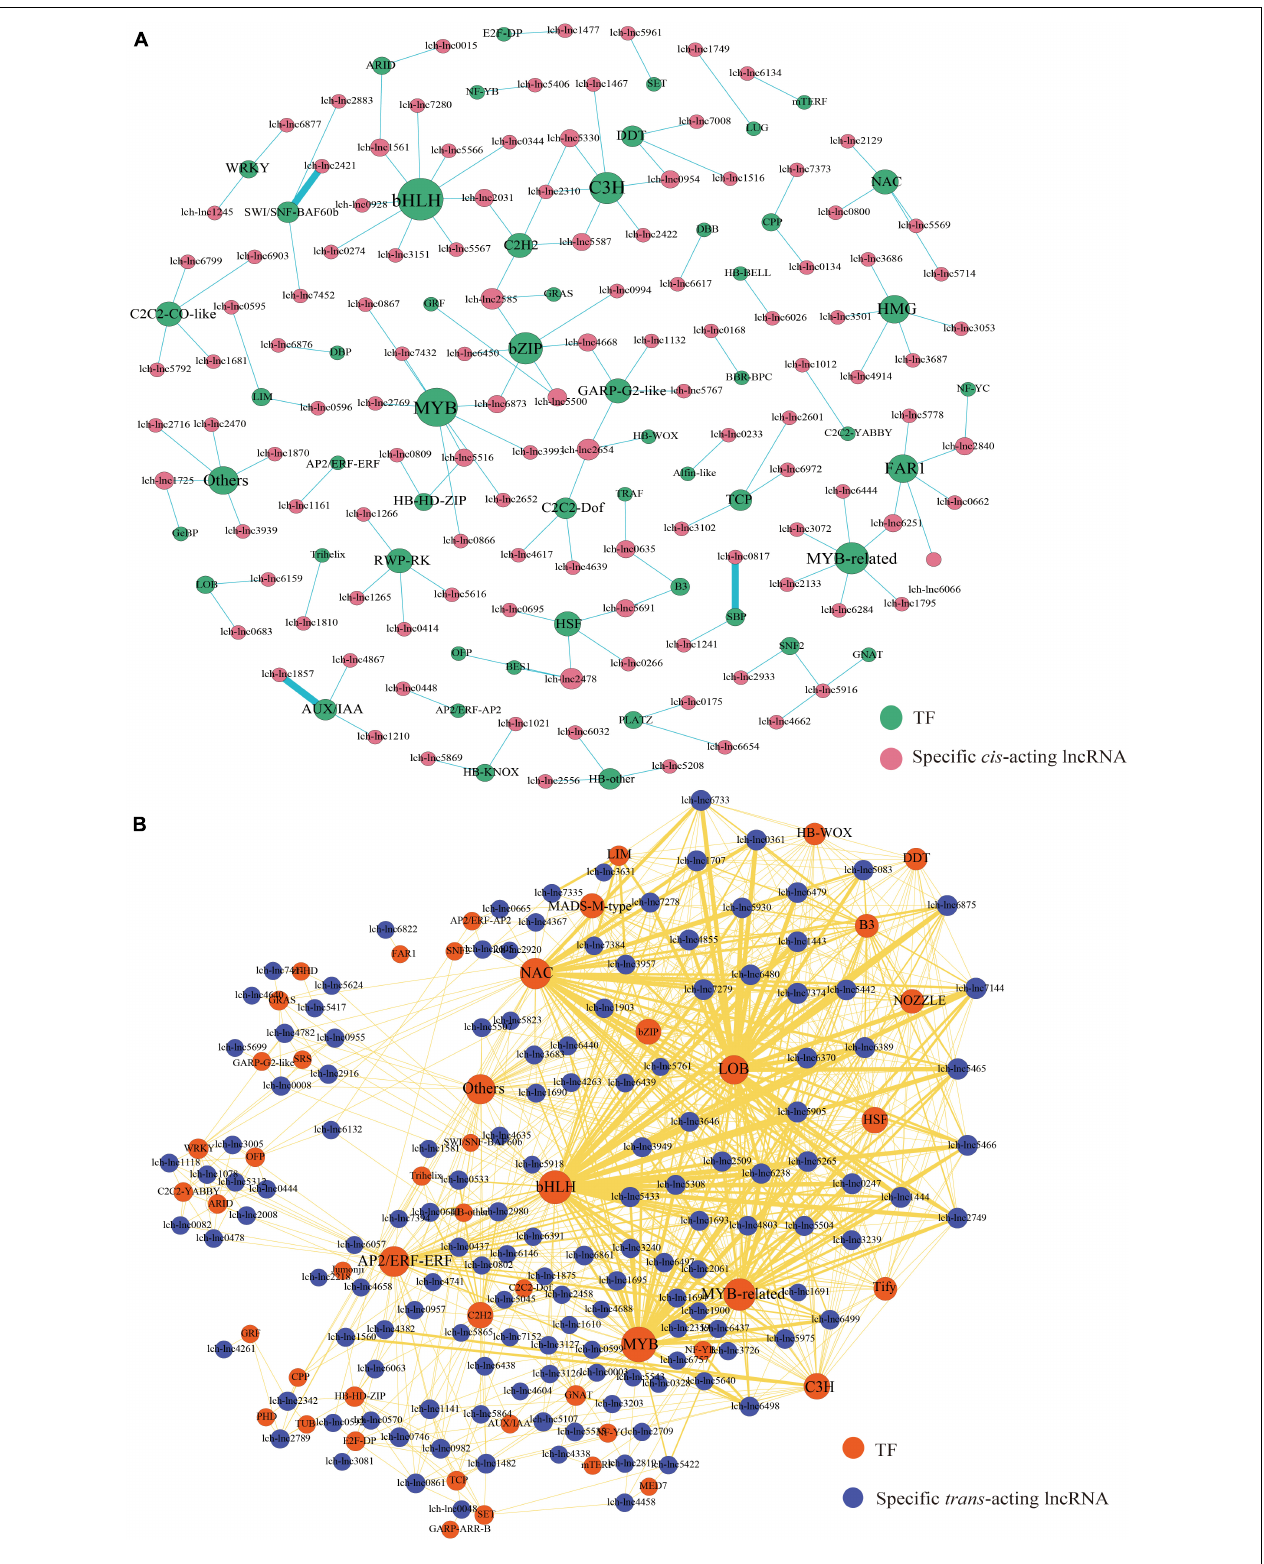
FIGURE 8 | LncRNAs and TFs regulatory network. The size of dot represents the number of TFs: the larger the dot, the more TFs. The wider the edge, the more TFs are targeted by specific lncRNAs. (A) Cis- acting lncRNAs-TFs regulatory network of L. chinense . (B) Ttrans- acting lncRNAs-TFs regulatory network of L. chinense .